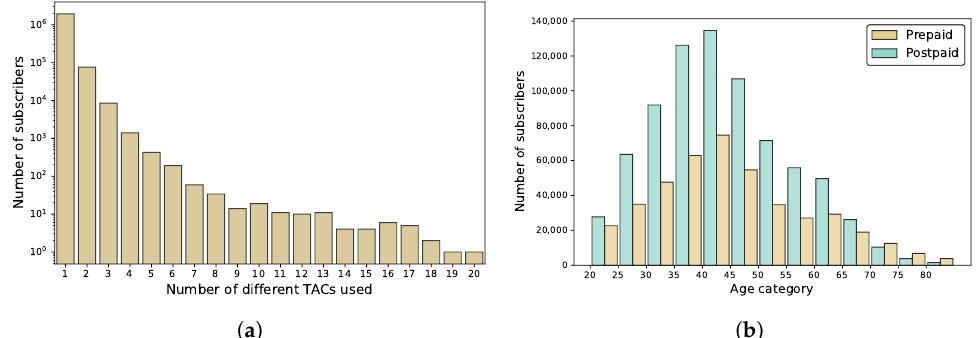
Figure 3. The number of different Type Allocation Codes (TAC) used by the subscribers ( a ), and the subscriber’ age distribution in respect of the subscription type ( b ).